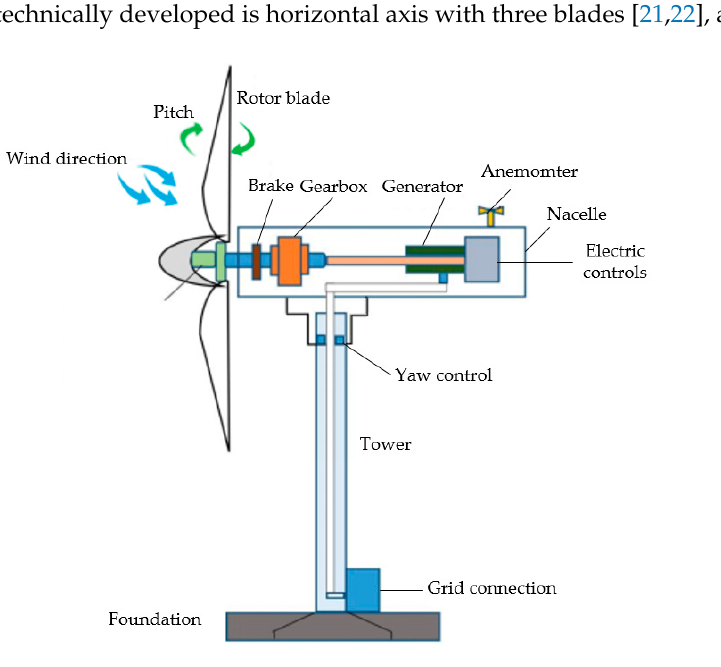
Table 1. Common types of wind turbines [19,20].